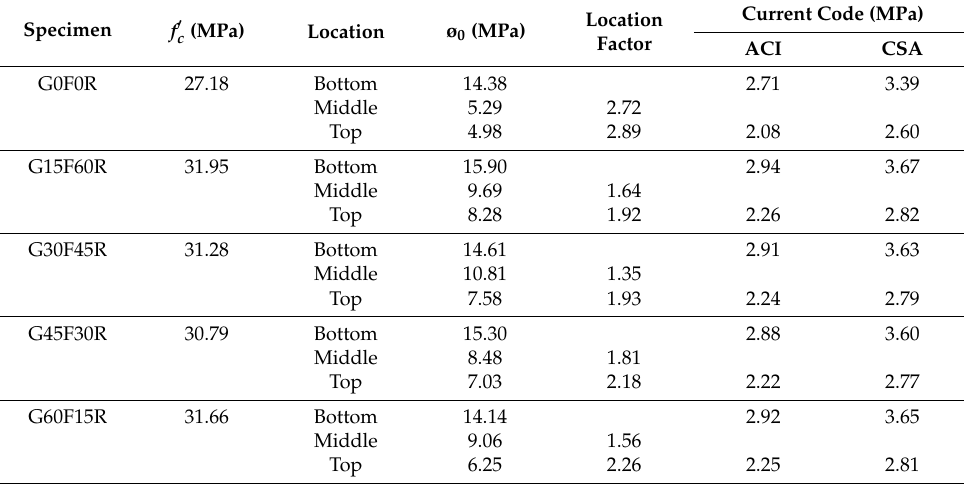
Table 9. Bond strengths of R-type